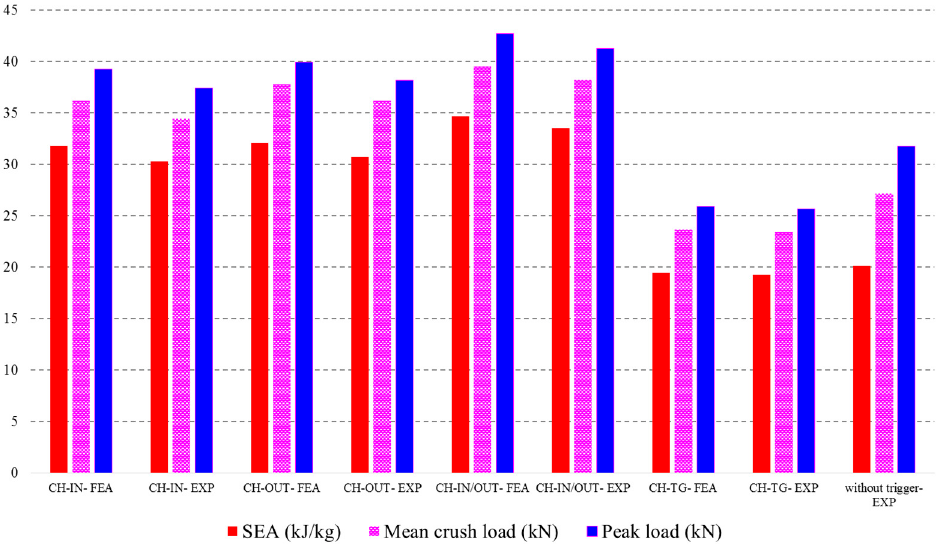
Figure 10. Representation of crashworthiness indicators from FE simulation and experimental data.